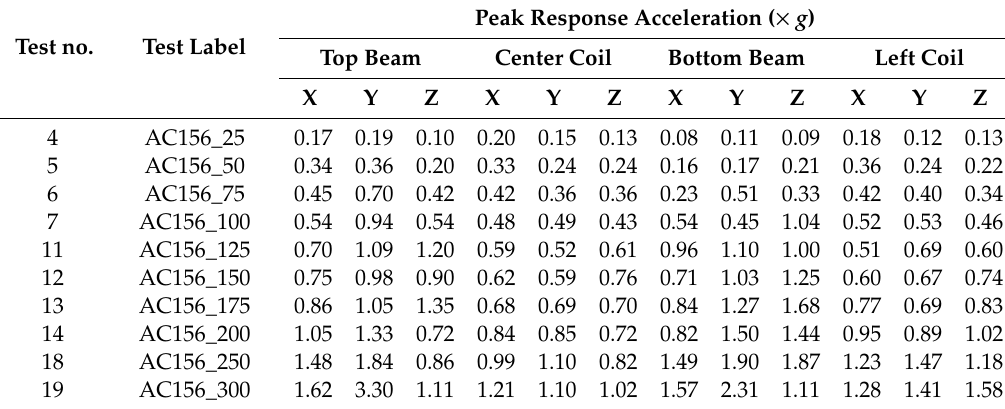
Table 4. Peak response acceleration of the test specimen at di ff erent